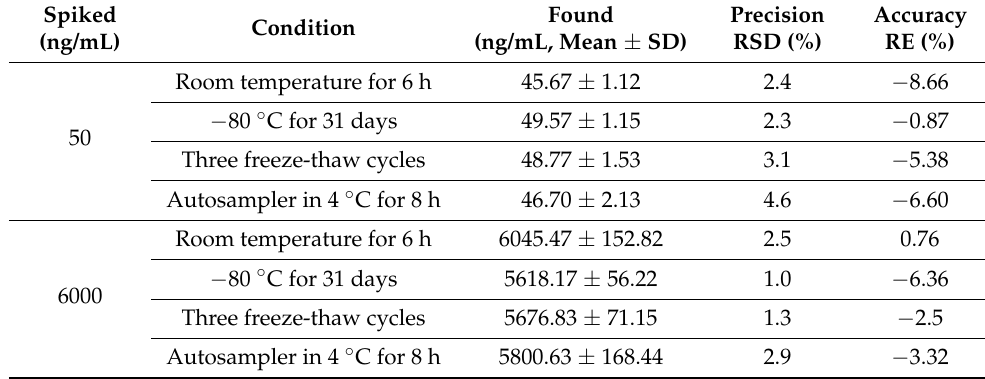
Table 4. Stability of venetoclax in plasma under different conditions. (mean ± SD, n = 3).